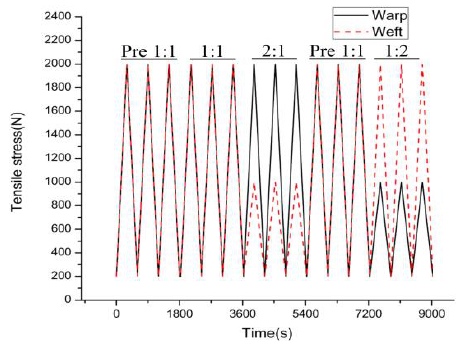
Figure 7. Test protocol.